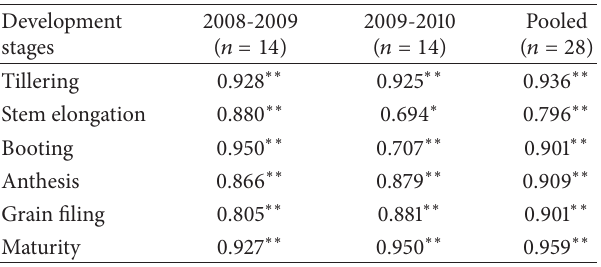
Table7:CorrelationcoefficientbetweengrainyieldandNDVIscore at different growth